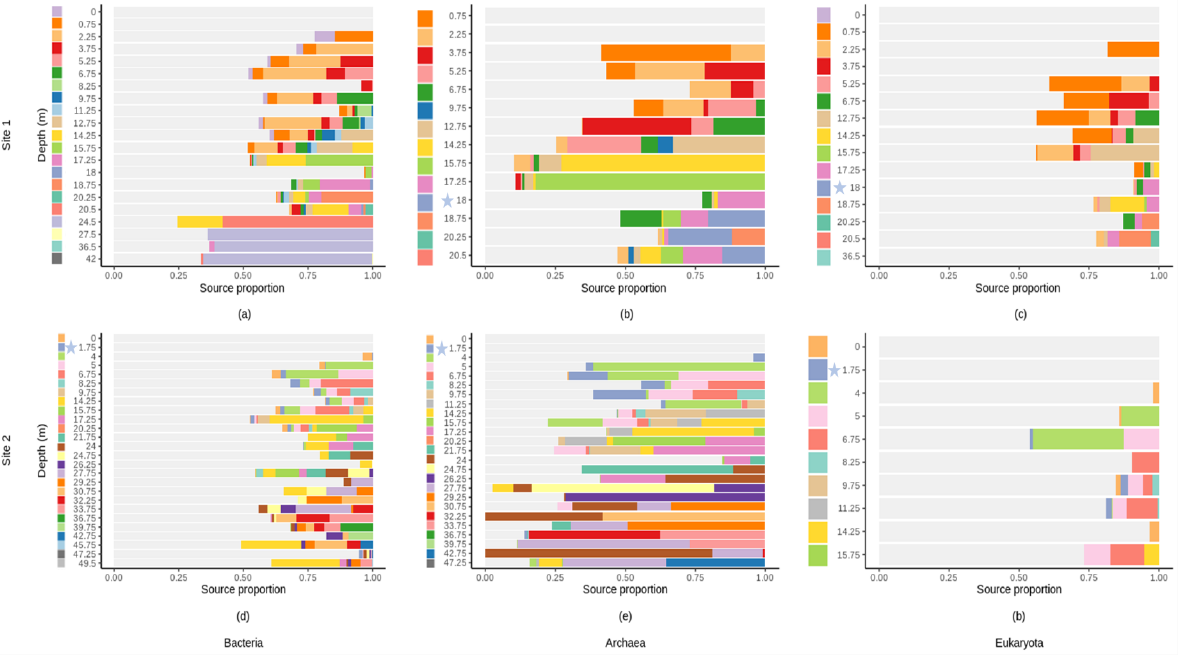
Figure 8. FEAST estimations of the proportion of communities from upper layers (source) contributing to the formation of communities in the deeper layer (sink) across different soil depths (m) at site 1 and at site 2. ( a , d ) for bacterial communities; ( b , e ) for archaeal communities; ( c , f ) for eukaryotic communities. The unknown sources are indicated in grey. Each color indicates the sources which are the microbial communities from each sample (e.g., in ( a ), the sample collected at depth 2.25 m has sources which are the microbial communities from the upper layers (the surface soil at depth 0 m (purple) and the soil layer at depth 0.75 m (orange)). Groundwater samples are located at 18 m and 1.75 m of depth, at site 1 and 2, respectively, and are indicated by blue stars.